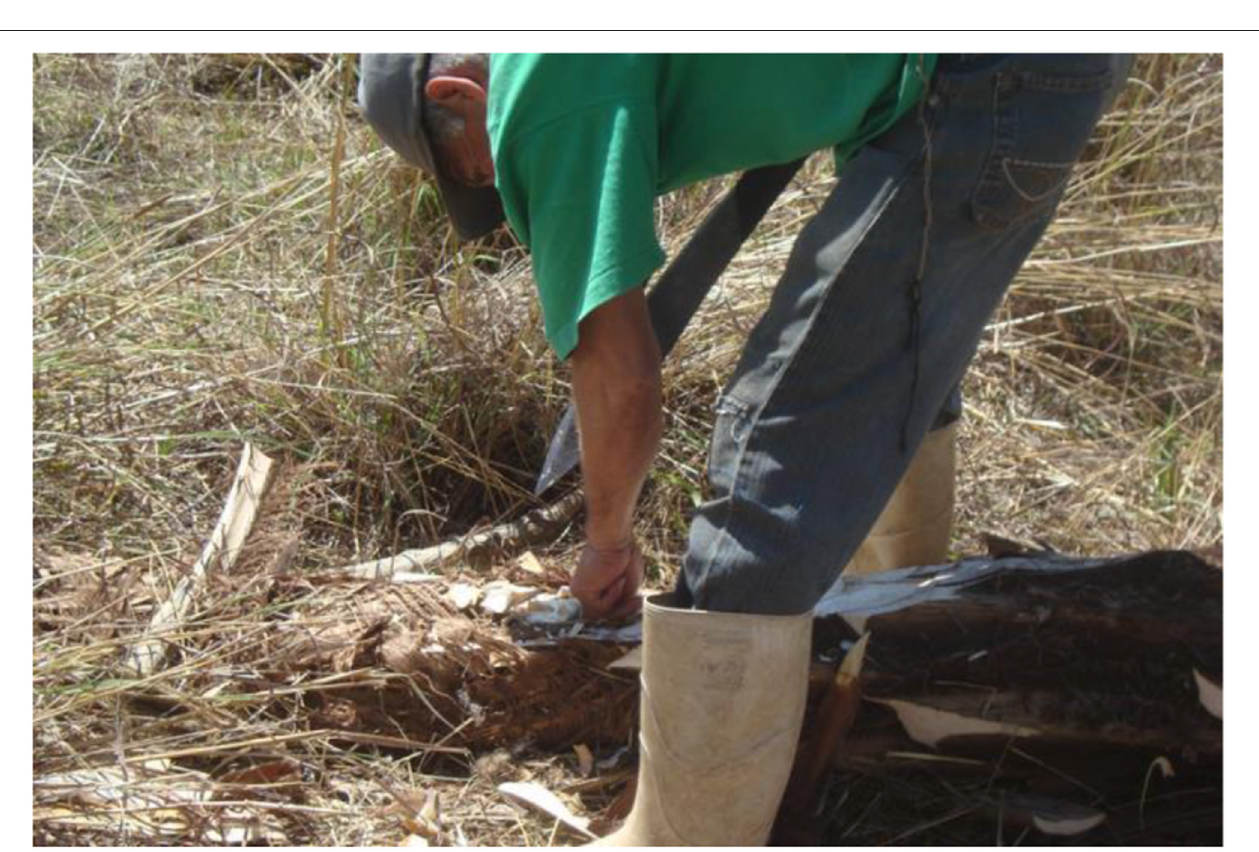
FIGURE 3 | Cutting of the palm trunk, for the formation of the “canoe,” from which the taberna will be obtained.